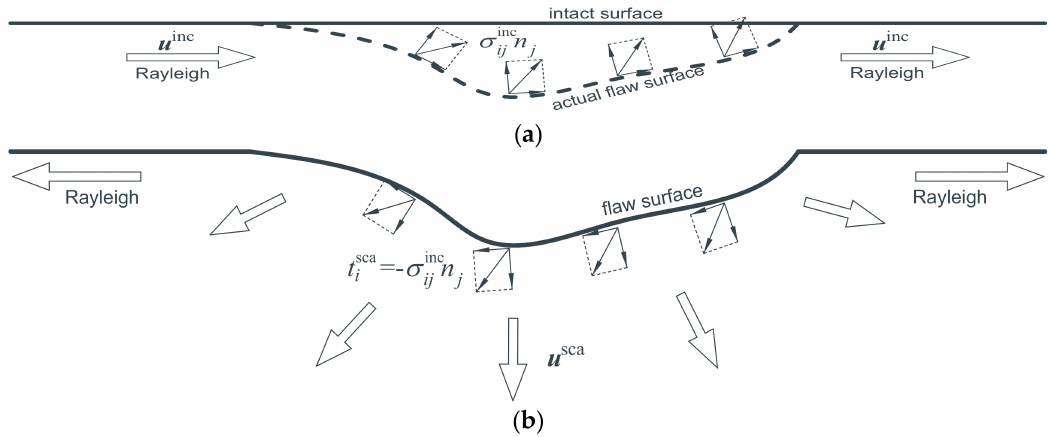
Figure 2. Two steps of calculating scattering wave field, ( a ) Step 1; ( b ) Step